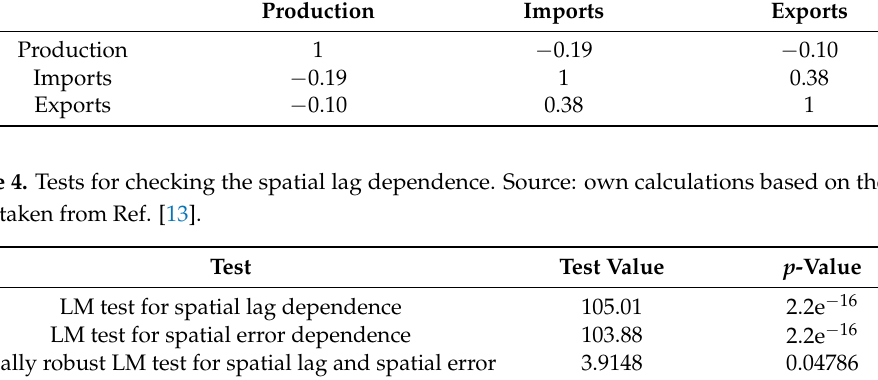
Table 3. Correlation matrix between vegetable production, imports, and exports.